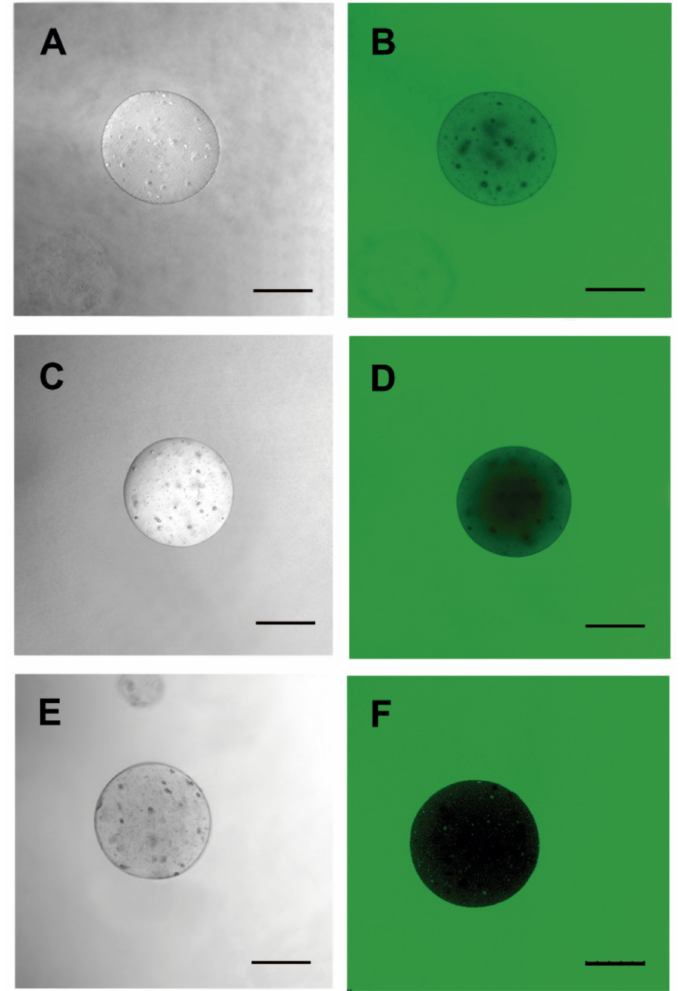
Figure 8. Porosity evaluation of the 3% sodium alginate membrane. Microcapsules containing HepG2 cells using fluorescein isothiocyanate (FITC)-dextran of di ff erent molecular weights were incubated for membrane permeability assessments. ( A , D ) 20 KDa; ( B , E ) 70 KDa and ( C , F ) 150 KDa. Images were obtained by fluorescence confocal microscopy and DIC (LEICA). Three independent experiments were carried out in triplicate. Bar 250 µ